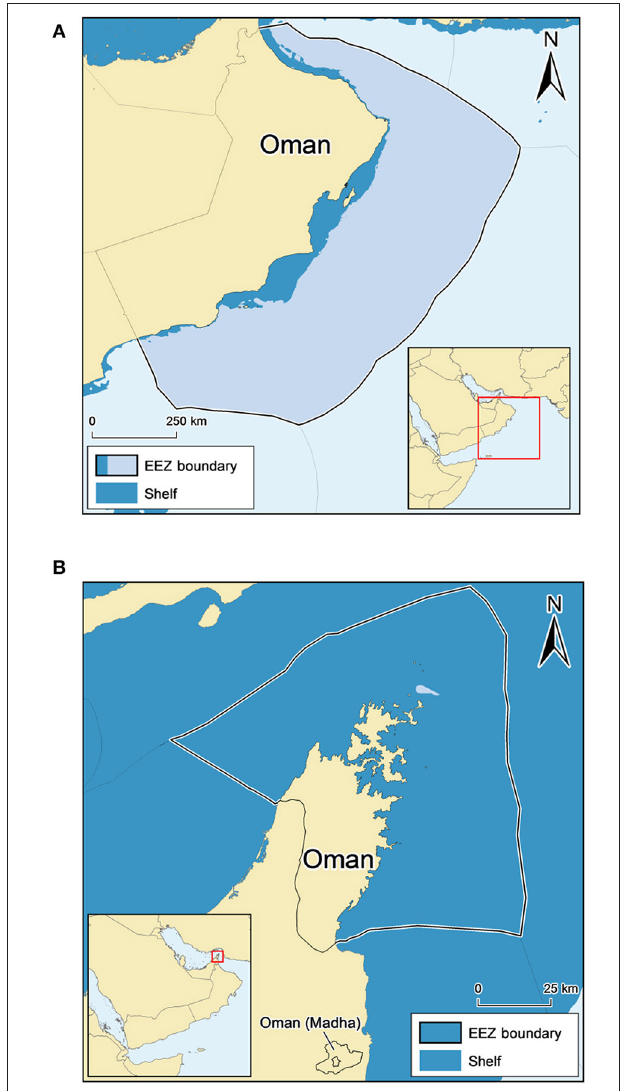
FIGURE 1 | (A) Oman (excluding Musandam), its shelf (to 200m depth) and Exclusive Economic Zone (EEZ). (B) The Musandam Peninsula (Oman), its shelf (to 200m depth) and Exclusive Economic Zone